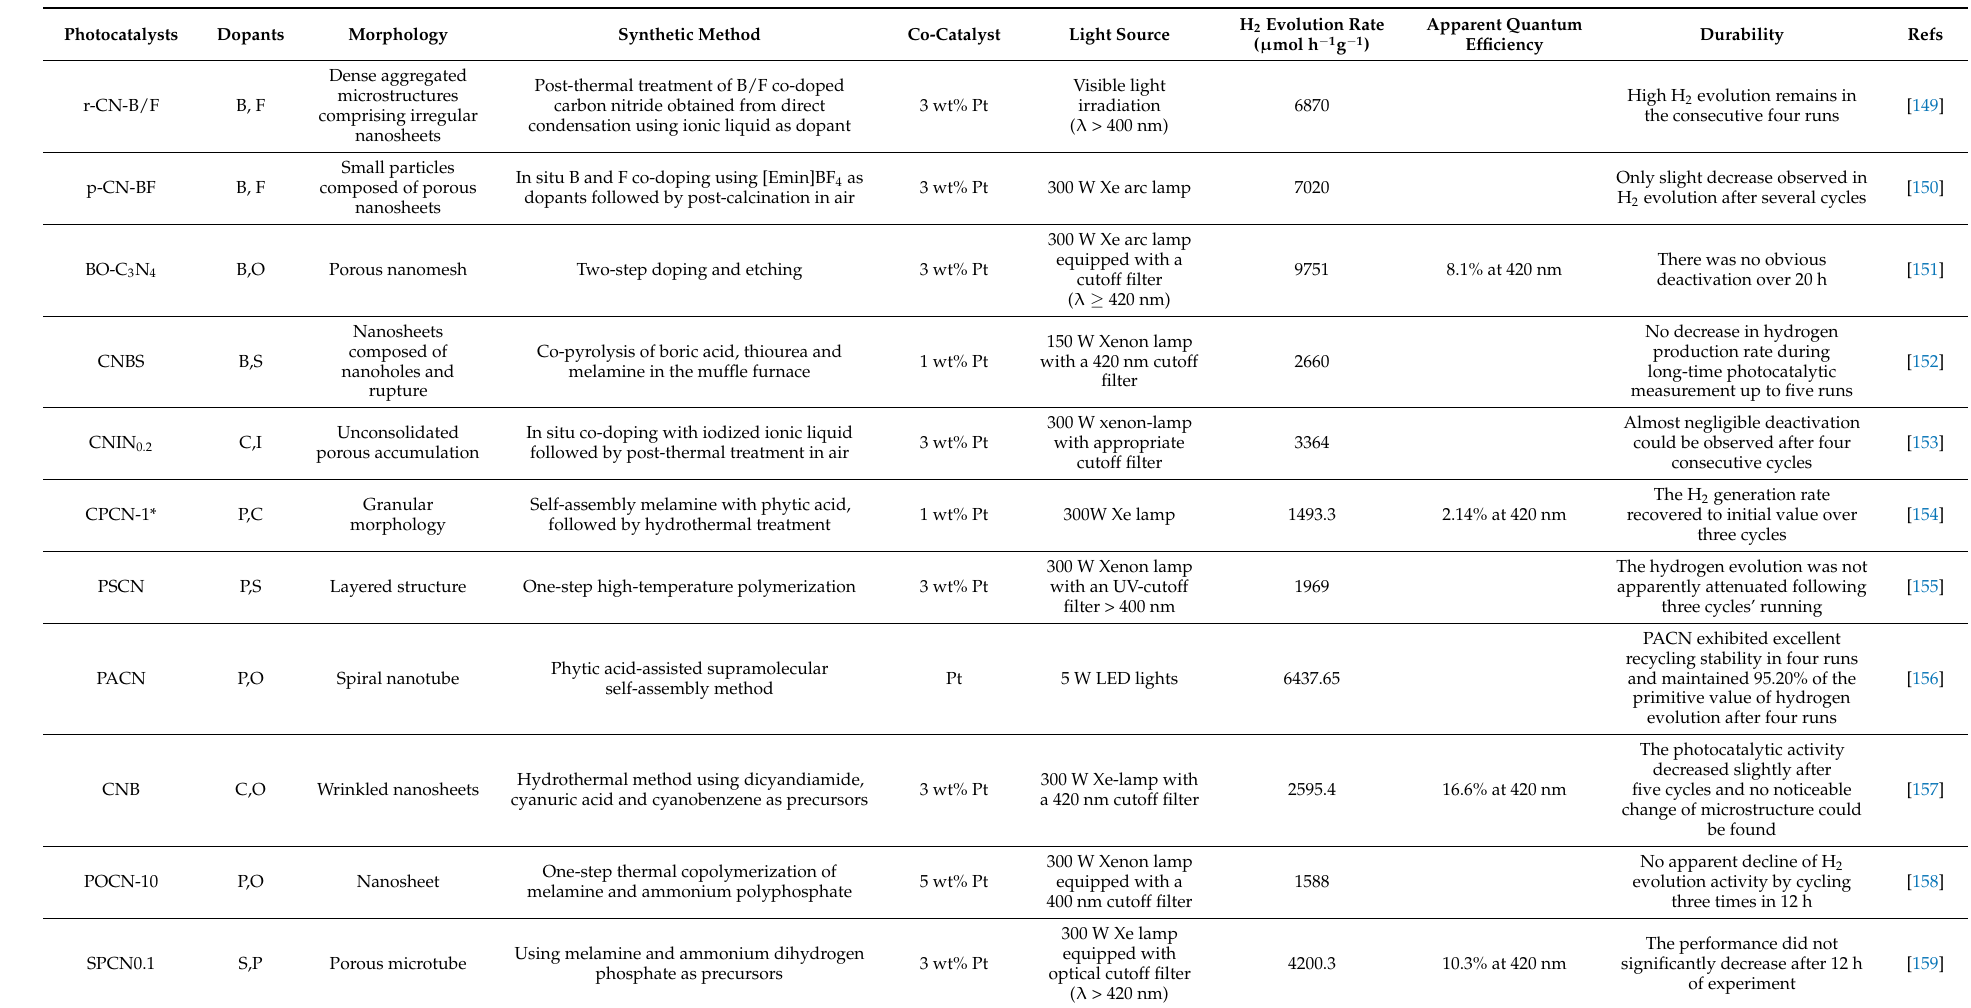
Table 7. Comparison of photocatalytic performance of binary heteroatom-co-doped porous carbon nitrides toward